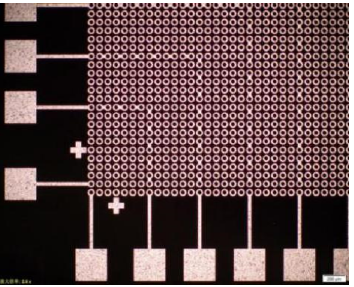
Figure 5. Partial array of wafers with only bumps and daisy chains.